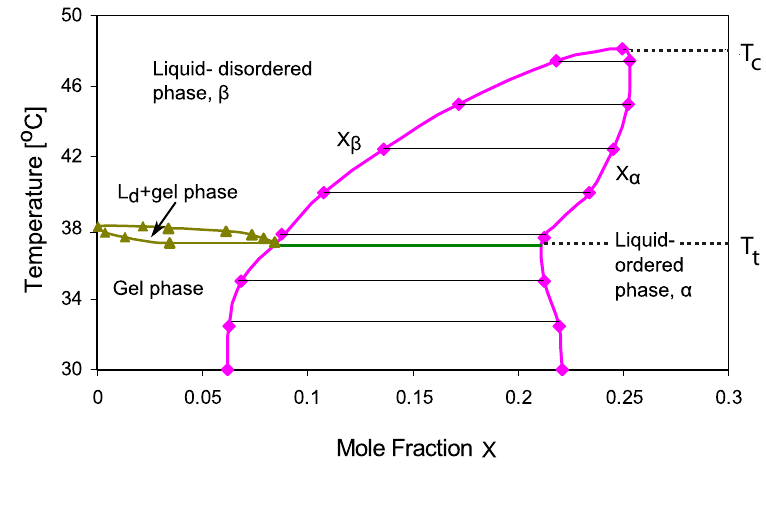
Figure 1. Generic phase diagram for mixed membranes consisting of cholesterol and a single phospholipid. The variable X represents the mole fraction of cholesterol; the phase a boundaries have been deduced from experiments on the phospholipid DPPC [8]. The fluid- fluid coexistence region between the liquid-ordered phase α on the right and the liquid- = X ( T ) and disordered phase β on the left is bounded by the two binodal lines X a a,β X = X ( T ) , which meet at the critical point with T = T . The horizontal broken lines a a,α c represent tie lines within the two-phase coexistence region. The triple point temperature is denoted by T t